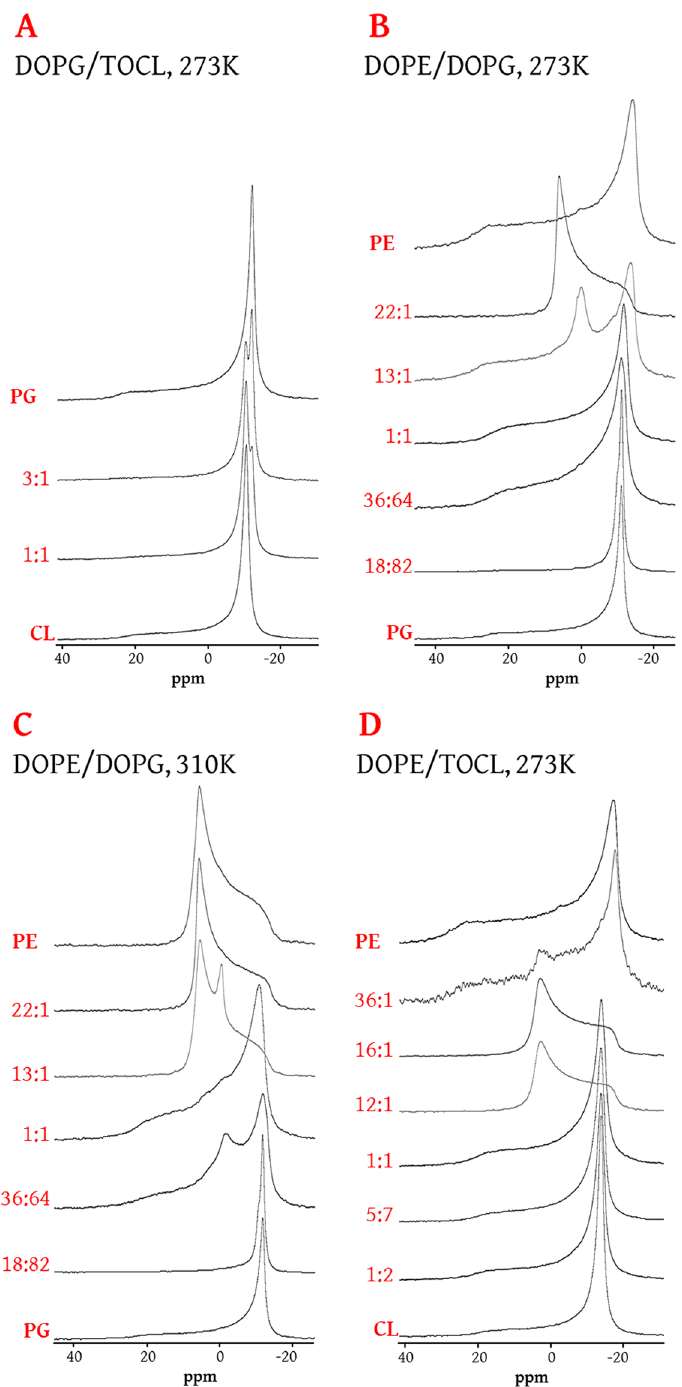
Figure 3. Stacked spectra showing the phase behaviour of two-lipid systems as a function of lipid head group composition. ( A ), DOPG/TOCL mixtures at 273 K; ( B ), DOPE/DOPG at 273 K; ( C ), DOPE/DOPG at 310 K; ( D ), DOPE/TOCL scan at 273 K. The 36:64 and 18:82 mixtures of DOPE:DOPG represent the ratio of these two lipids in the B period and at the C/D boundary, respectively. DOPG, dioleoylphosphatidylglycerol; TOCL, tetraoleoylcardiolipin; DOPE, phosphatidylethanolamine. Full temperature scans of each lipid mixture can be found in Figs